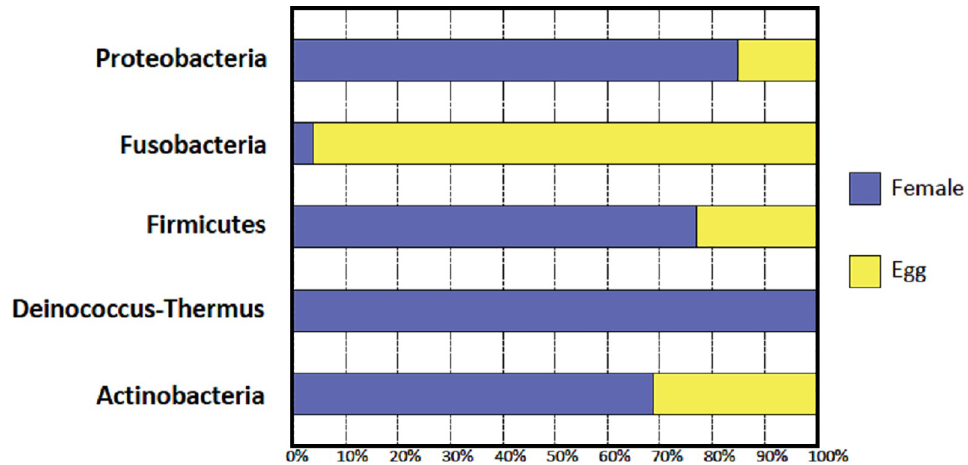
Fig 2. Relative abundance of H . anatolicum gut and egg bacterial phyla revealed by 16S rRNA gene sequencing on the Illumina MiSeq platform.